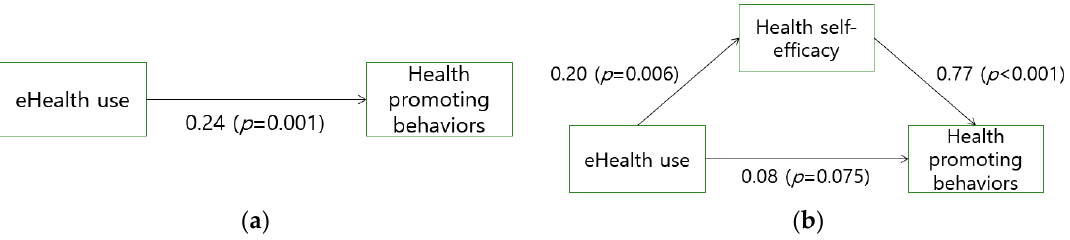
Figure 1. Relationship of eHealth use, health self-efficacy, and health-promoting behaviors. ( a ) Direct